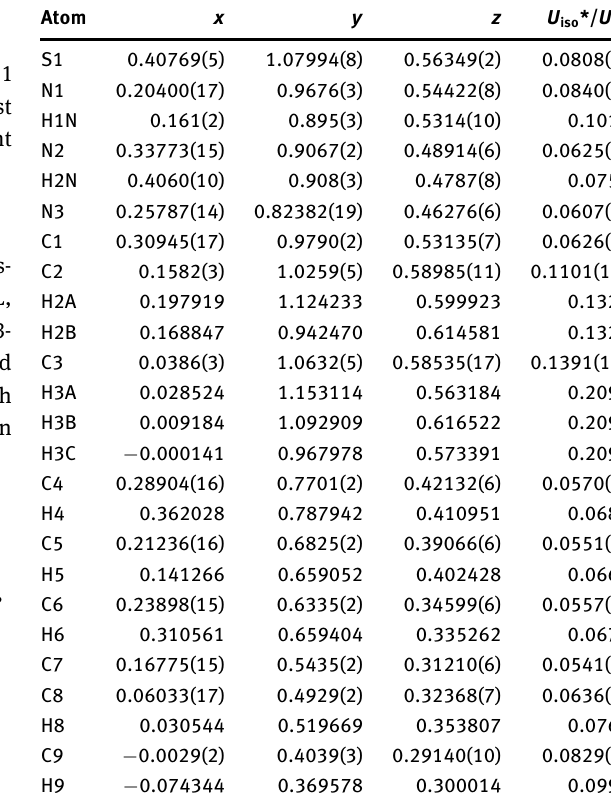
Table 2: Fractional atomic coordinates and isotropic or equivalent isotropic displacement parameters (Å 2